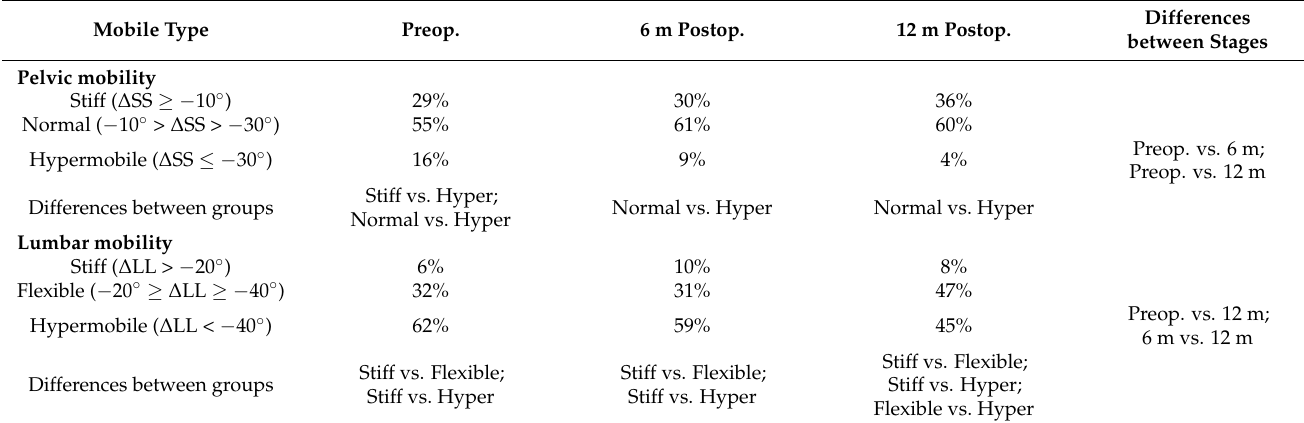
Table 4. The distribution of the patients preoperatively (preop.) and 6 (6 m) and 12 months (12 m) postoperatively (postop.) for pelvic mobility (Stiff, normal and hypermobile (hyper)), lumbar mobility (Stiff, flexible, and hypermobile).